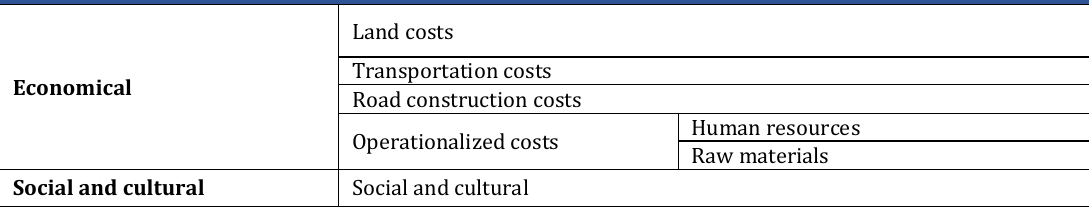
Table 4: The main criterion of the costs for site selection of new energies production from cellulosic materials